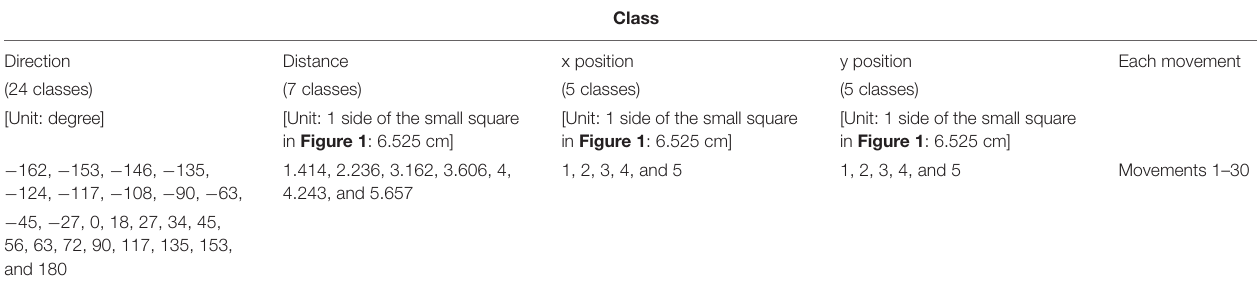
TABLE 1 | The five classes used for